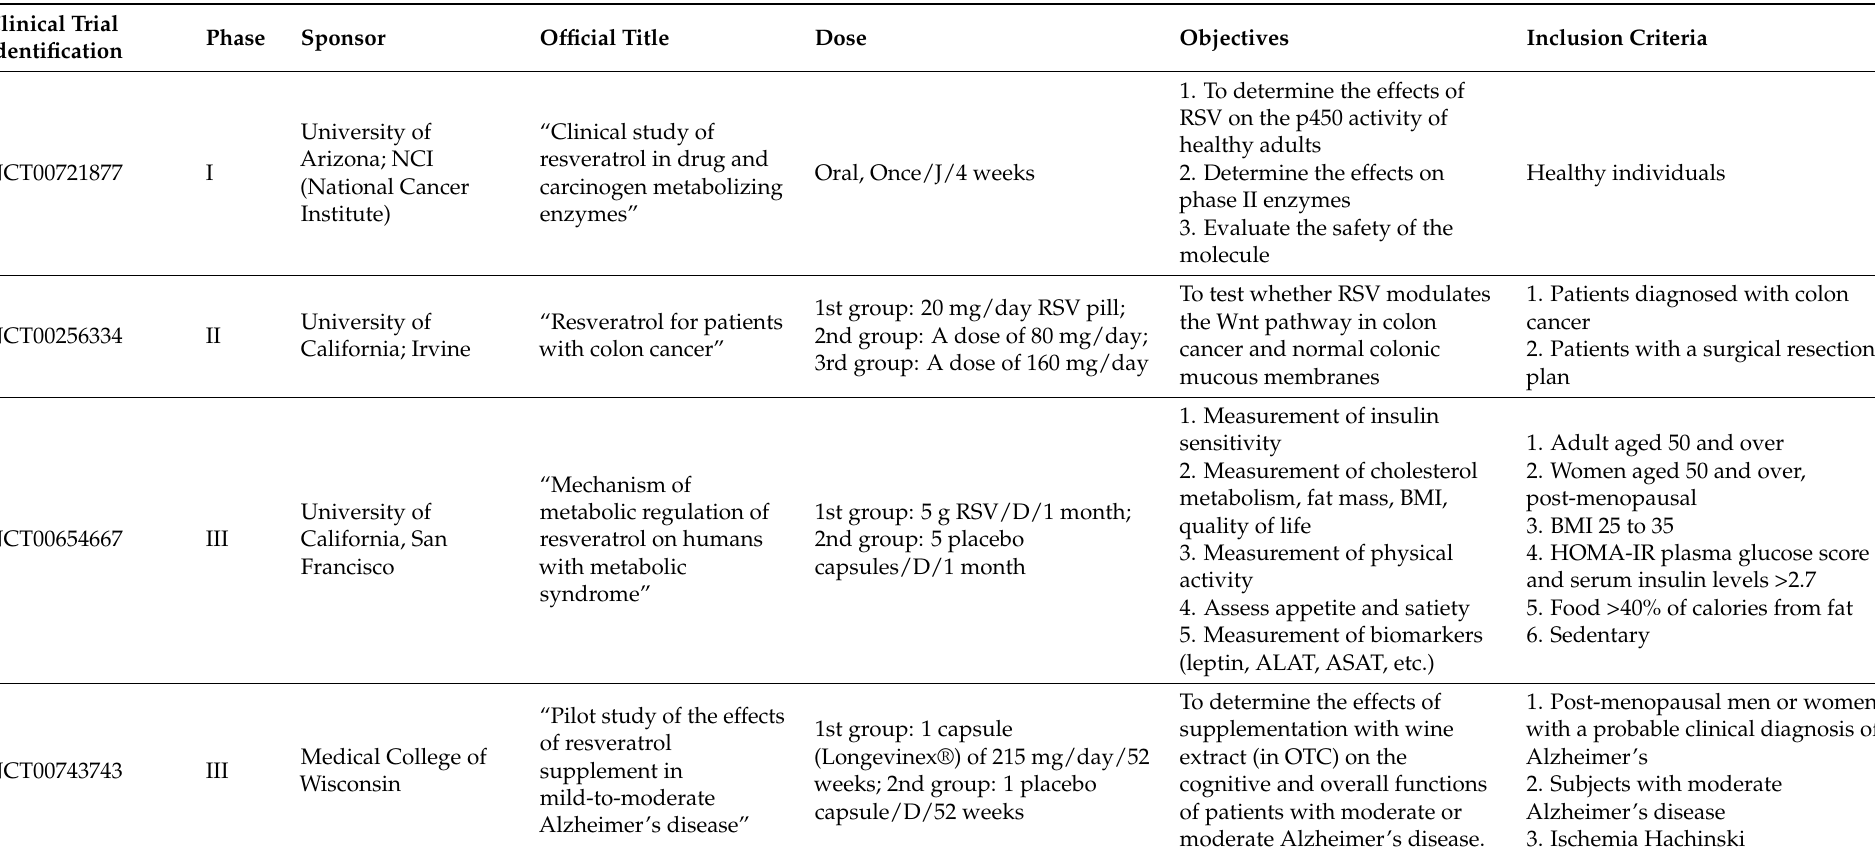
Table 3. Clinical trials in